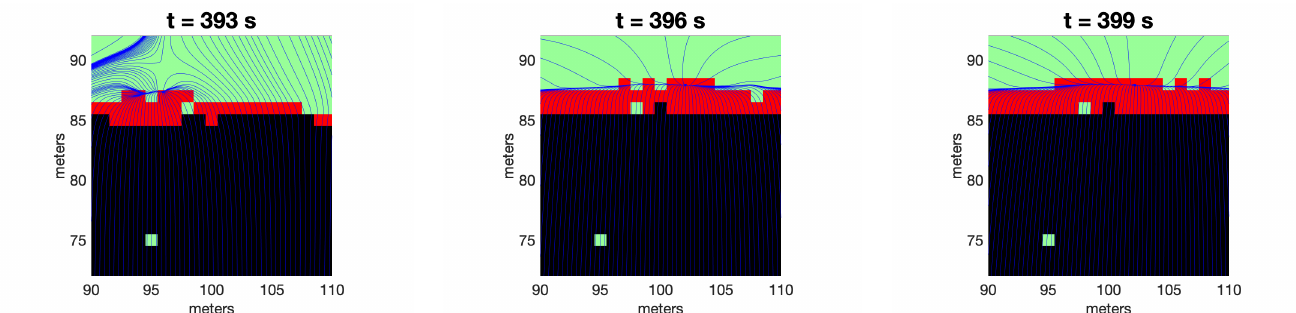
Figure 6. A configuration resulting in a fast rate of spread of 0.14 m/s. As the fire line is thinner than in Figure 5, less time is required for the fire to propagate